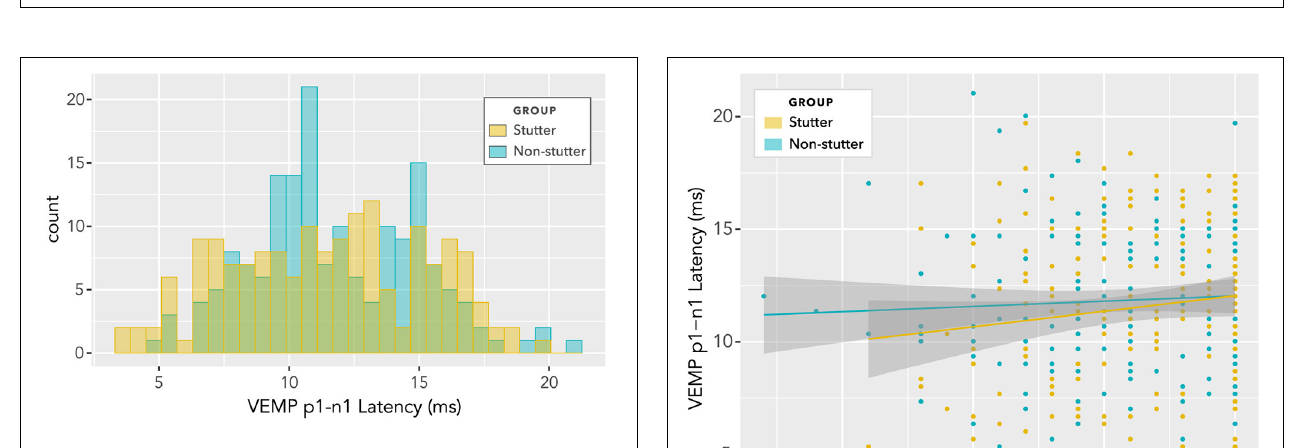
FIGURE 12 | Histogram of VEMP p1-n1 latencies for stutter and control groups. The histogram does not show detail of participant or stimulus level, and contains repeated measurements for the two groups of 15 participants per group. As such, it suggests shape of distribution and direction of group difference, but is not appropriate for statistical comparison (statistical comparison is by linear mixed-effects regression modelling).